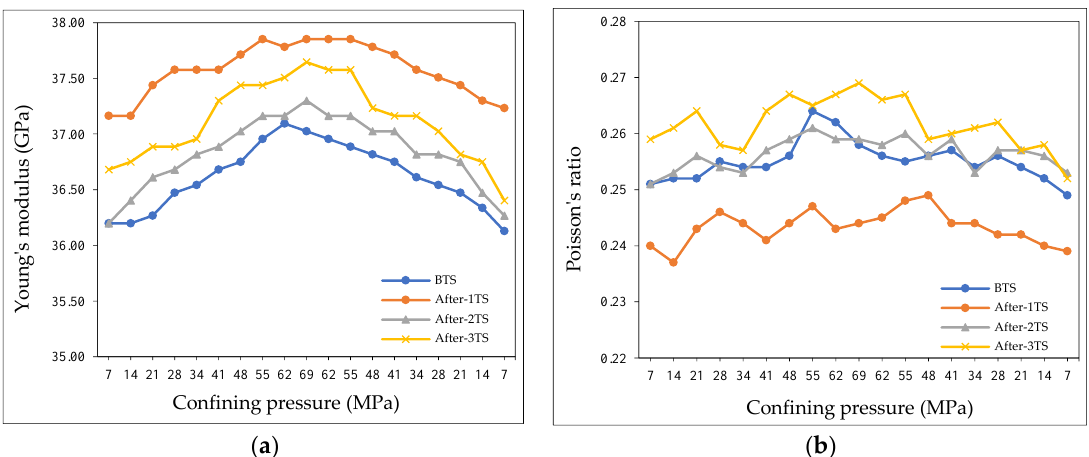
Figure 8. ( a ) Young’s modulus results of EF#5 at different confining pressures before and after thermal shock; and ( b ) Poisson’s ratio results of EF#5 at different confining pressures before and after thermal shock.